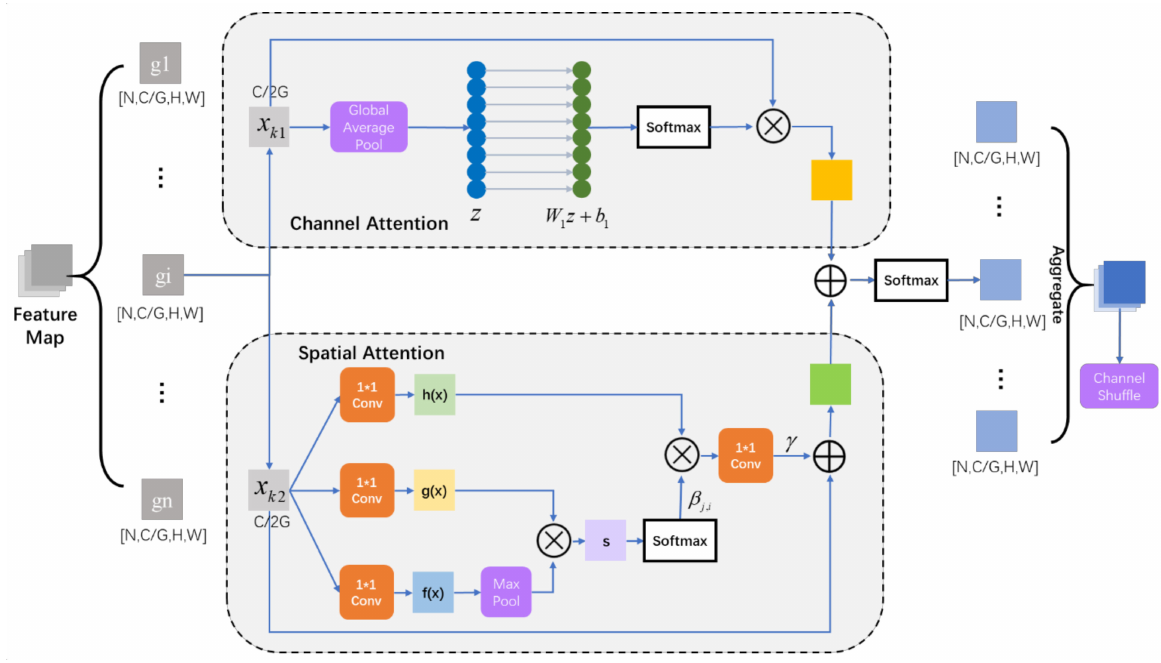
Figure 3. The structure of the modified shuffle attention